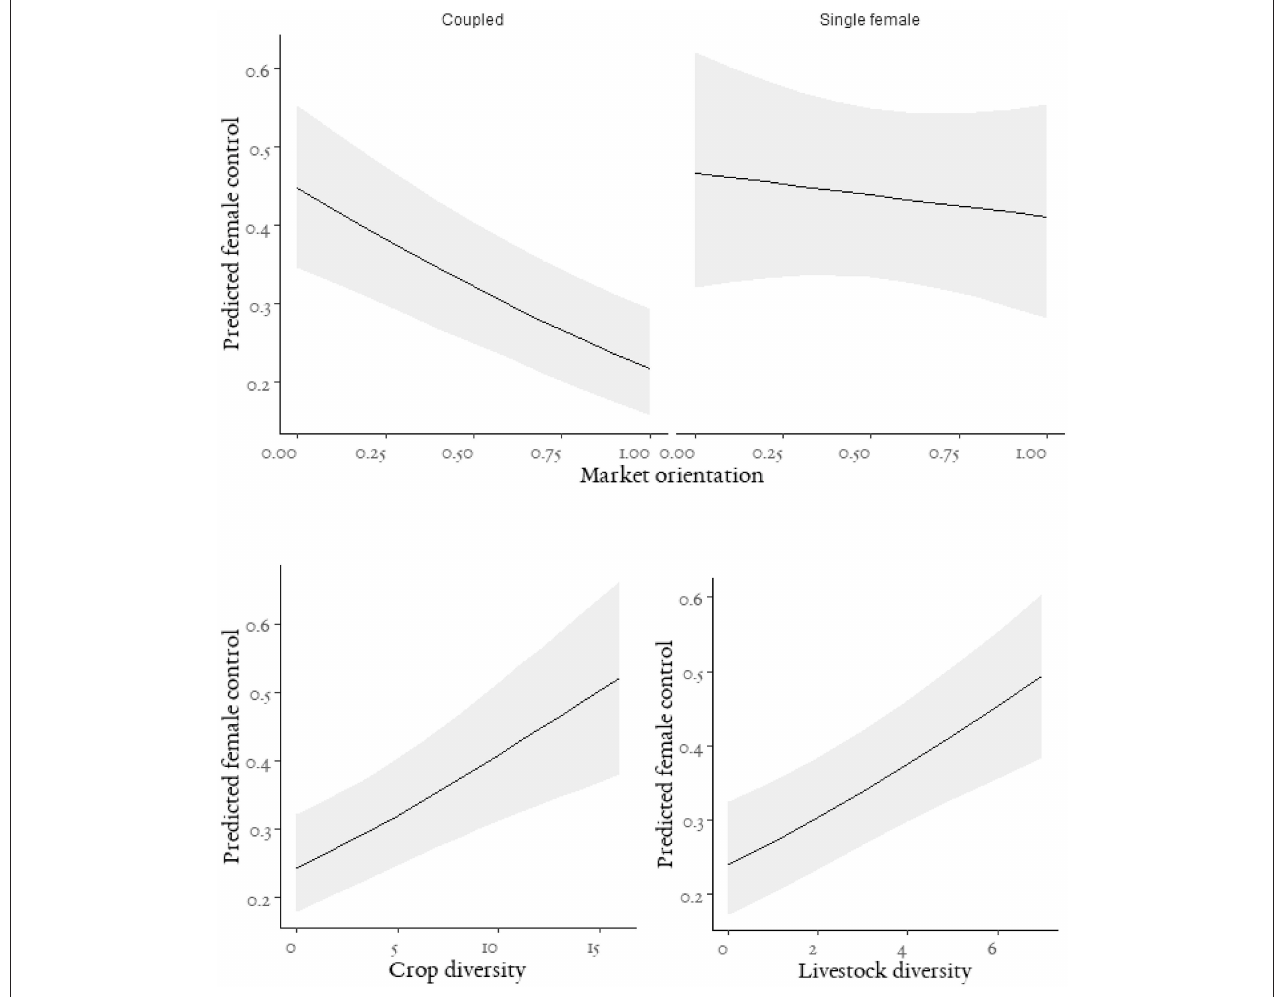
FIGURE 1 | Predicted marginal